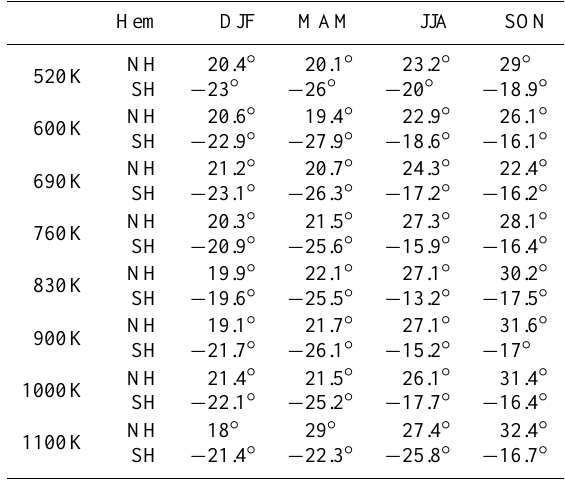
Table 3. The subtropical barrier latitude as a function of seasons in the NH and SH at different potential temperature levels. The data are averages of MLS, MIPAS, SMR, and